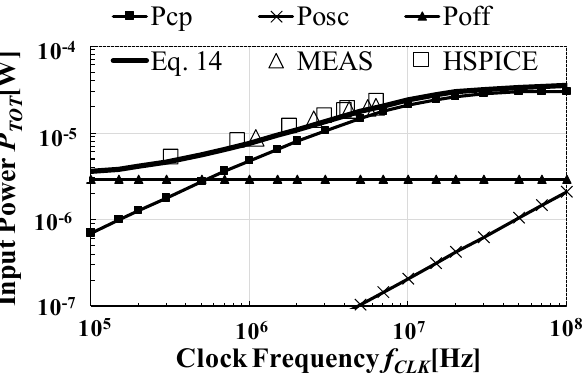
Figure 15. Measured I OUT (cid:3364)(cid:3364)(cid:3364)(cid:3364)(cid:3364)(cid:3364) as a function of V OUT ( f IN = 1 kHz, f CLK = 5 MHz).